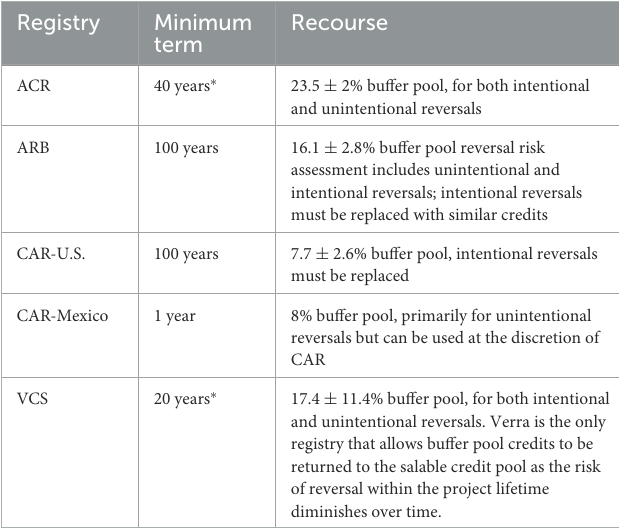
TABLE 4 Durability terms and buffer pool contributions ( ± one standard deviation) across offset